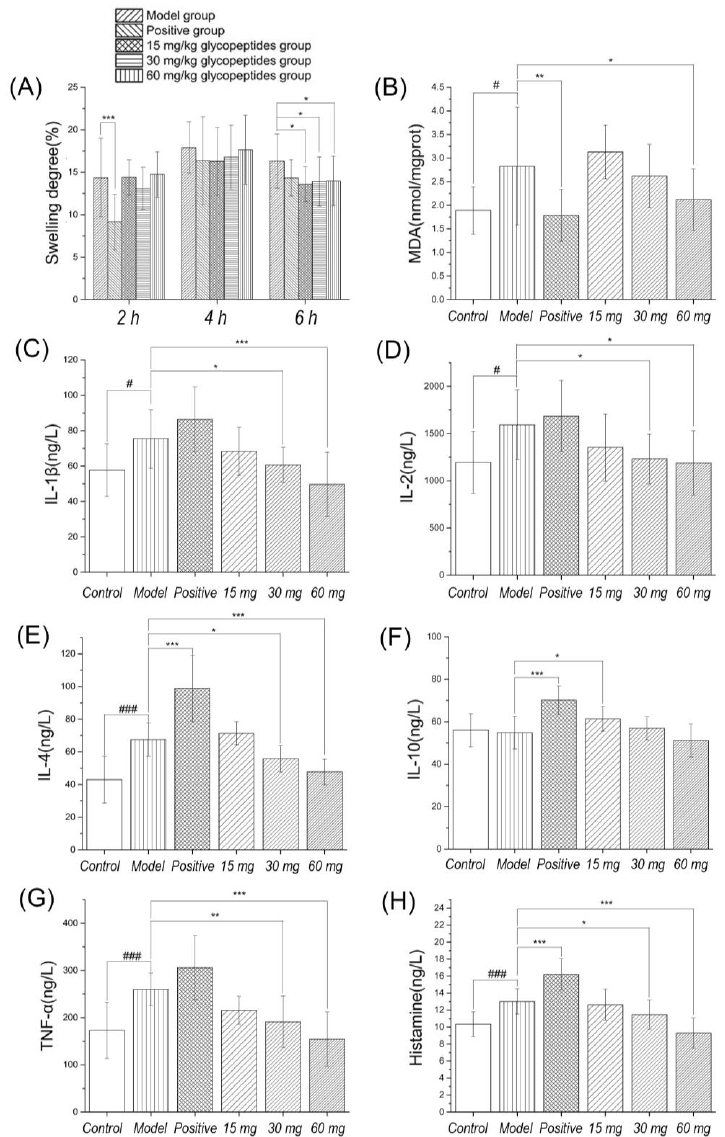
Figure 2. Effect of Gg on foot swelling of rats in the carrageenan inflammatory pain model. ( A ) Effect of Gg on foot swelling degree of rats induced by carrageenan. ( B ) Effect of Gg on MDA of inflammatory foot tissue in the carrageenan inflammatory pain model. ( C – H ) Effect of Gg on IL-1β, IL-2, IL-4, IL-10, TNF-α and Histamine of inflammatory foot tissue in the carrageenan inflammatory pain model, respectively. There were significant difference between positive control (Diclofenac sodium) and model group in swelling degree at 2 h, and there were significant differences between low to high dose of Gg and model group in swelling degree at 6 h. There were significant differences between positive control and model group in MDA, IL-4, IL-10 and Histamine. There were significant differences between moderate to high dose of Gg and model group in IL-1 β , IL-2, IL-4, TNF- α and Histamine ( p < 0.05–0.001). Low dose Gg group exhibited only significant increase in IL-10. # p < 0.05, ### p < 0.001, * p < 0.05, ** p < 0.01, *** p <